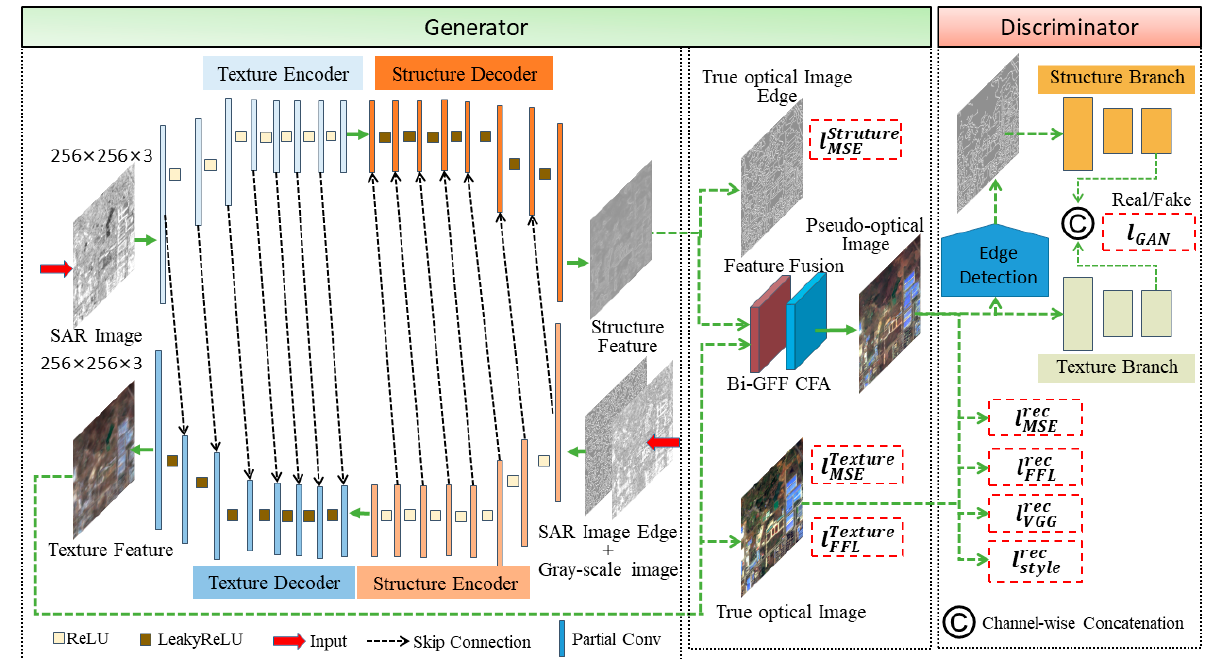
Figure 2. The generators and discriminator of our network. Generators : The SAR-to-optical translation process is divided between two generators, i.e., a structure generator and a texture generator, which borrow each other’s depth features, and the Bi-GFF and CFA modules are used to refine and fuse the features from these structure and texture reconstruction branches to form the final pseudo-optical image. Discriminator : The texture branch guides texture generation, and the structure branch guides structure generation.